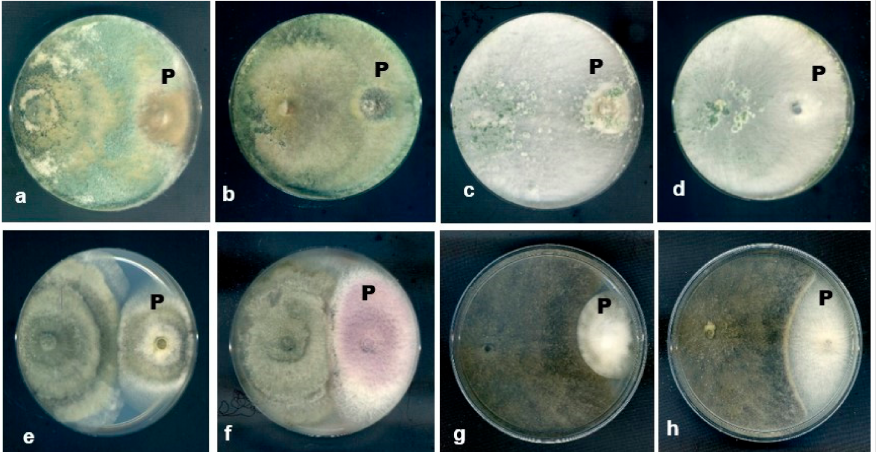
Figure 11. Antagonistic activity of endophytic fungi against several plant pathogenic fungi (P) on dual culture plates. T. harzianum overgrew ( a ) C. scovellei and ( b ) C. truncatum ; T. koningiopsis overgrew ( c ) C. scovellei and ( d ) C. truncatum ; E. endophytica moderately inhibited ( e ) L. theobromae and ( f ) F. oxysporum ; and D. tectonae moderately inhibited ( g ) C. scovellei and ( h ) F.